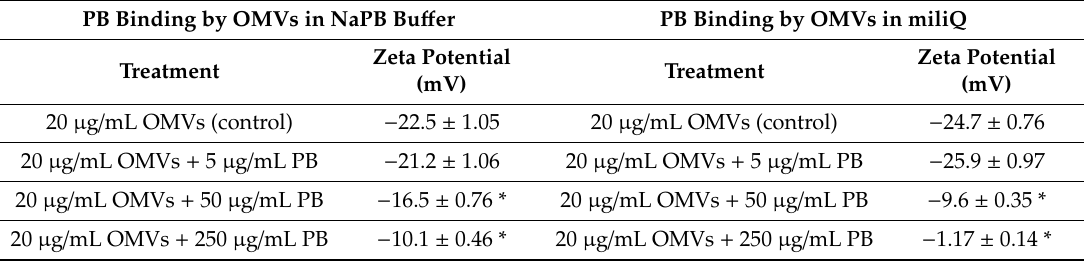
Table 1. Alteration in Zeta potential of OMVs treated with polymyxin